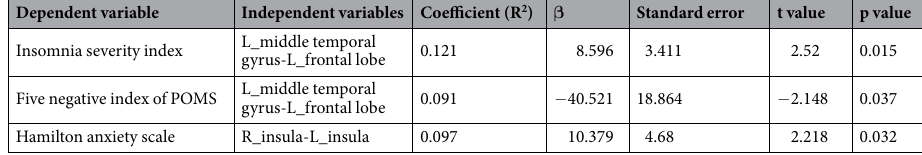
Table 5. Multiple linear regression analysis between functional connectivity and behavioral performances in PIs. Abbreviations: PIs, patients with primary insomnia; POMS, Profile of mood